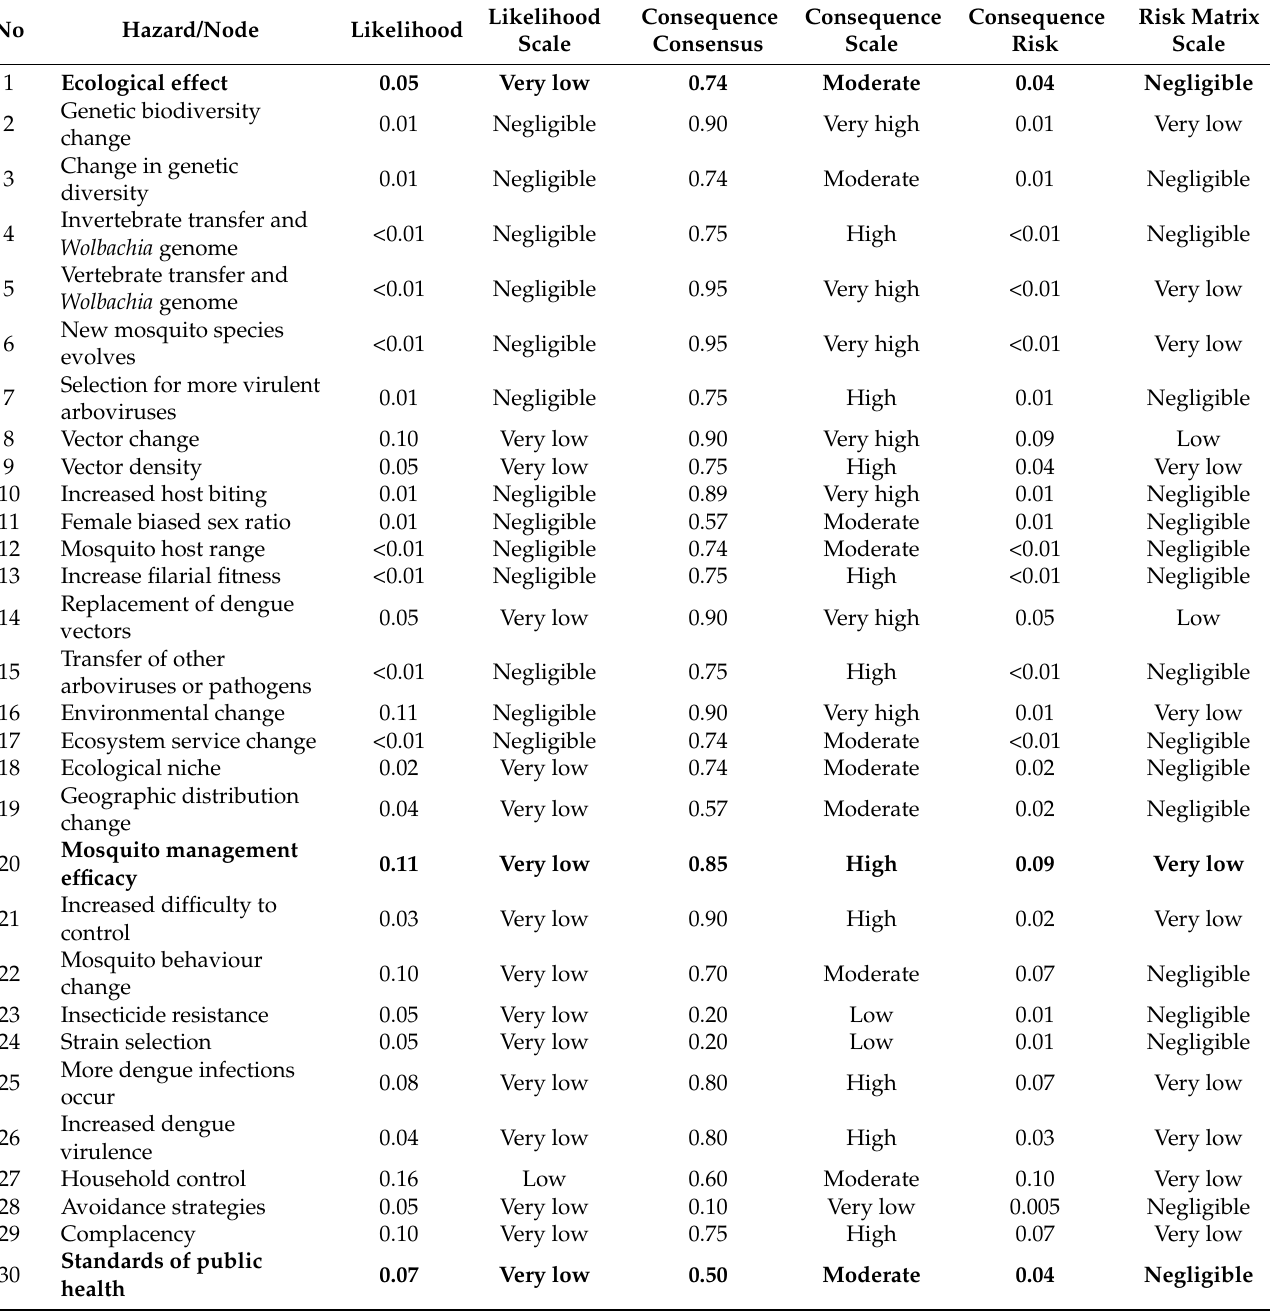
Table 5. Consensus of estimation of likelihood, consequence and risk (ranked by risk) for the endpoint “cause more